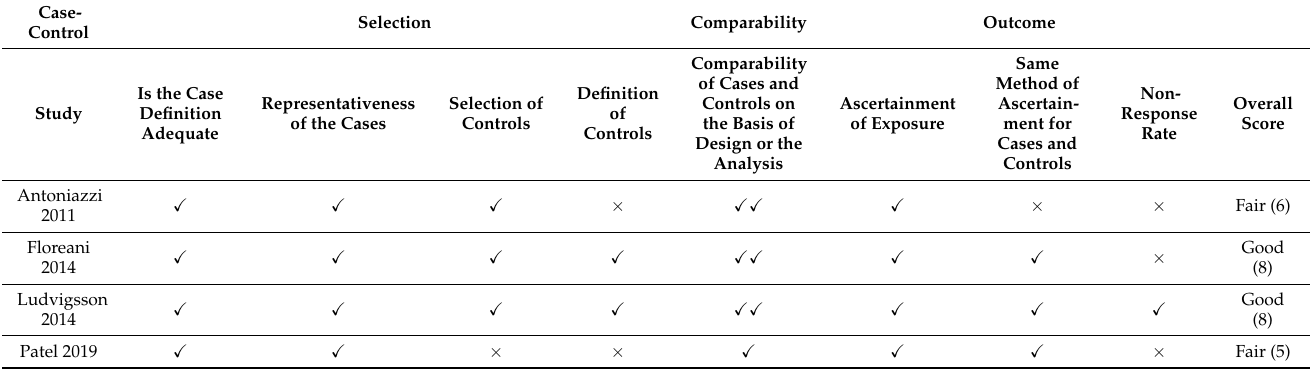
Table 5. Quality assessment of individual case-control studies using the Newcastle-Ottawa Scale.